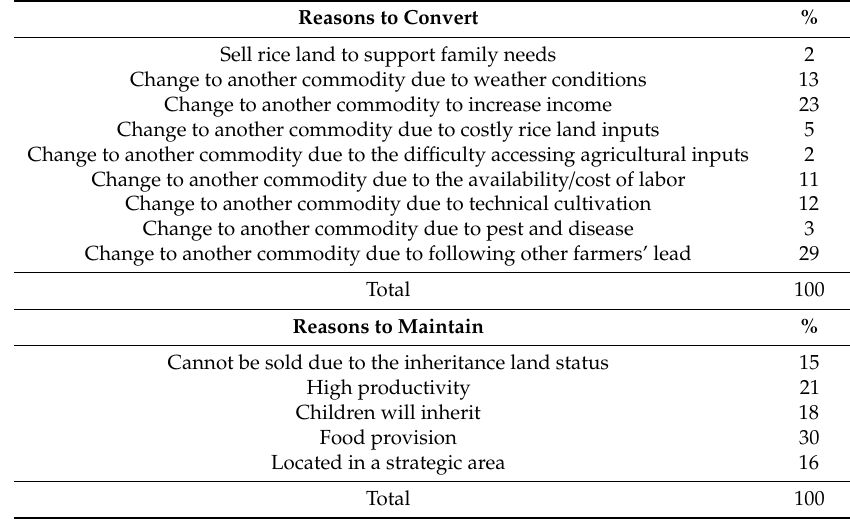
Table 9. Respondents’ reasons to convert and maintain their rice land ( n = 180).